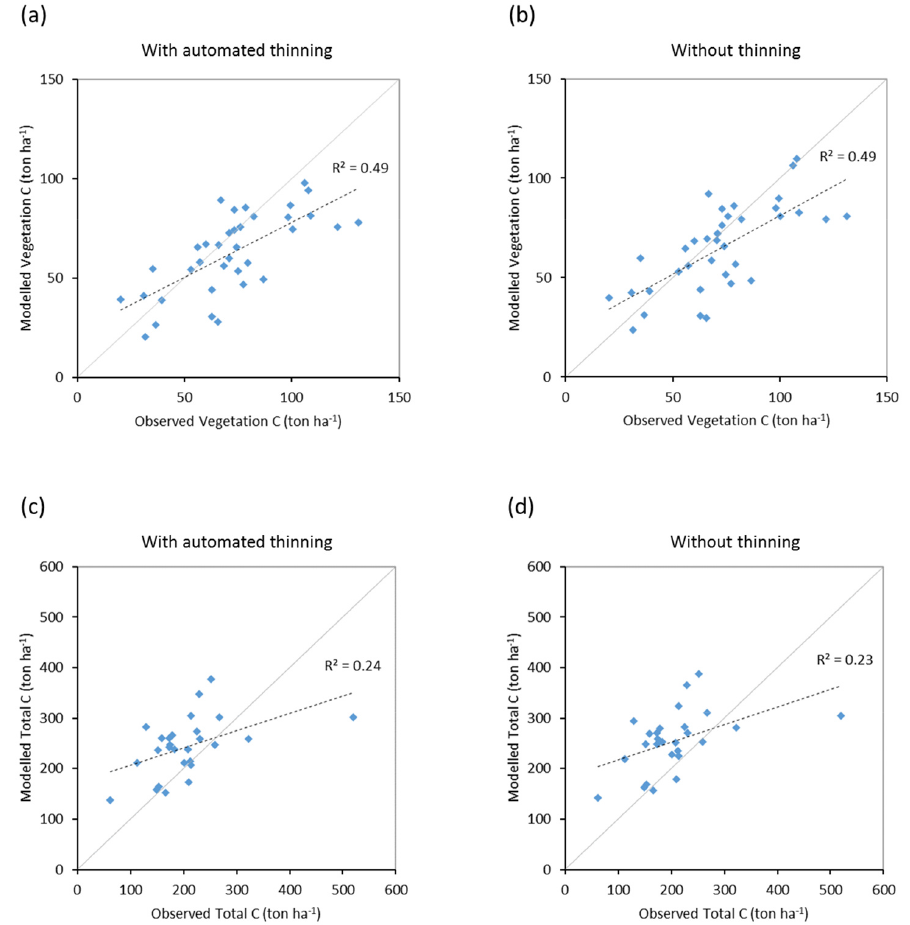
Figure 9. Modelled and observed (Forest Europe, 2015) values for individual European countries, excluding Georgia, Iceland, Cyprus, Malta, and Russia, in 2010. Vegetation carbon (a) simulation with automated thinning and (b) simulation without thinning. Total carbon pool (c) simulation with automated thinning and (d) Simulation without thinning. In (c) and (d) , countries missing Forest Europe soil data, i.e. Bosnia, Croatia, Greece, Hungary, Macedonia, Moldova, Montenegro, Norway, and Portugal, are also